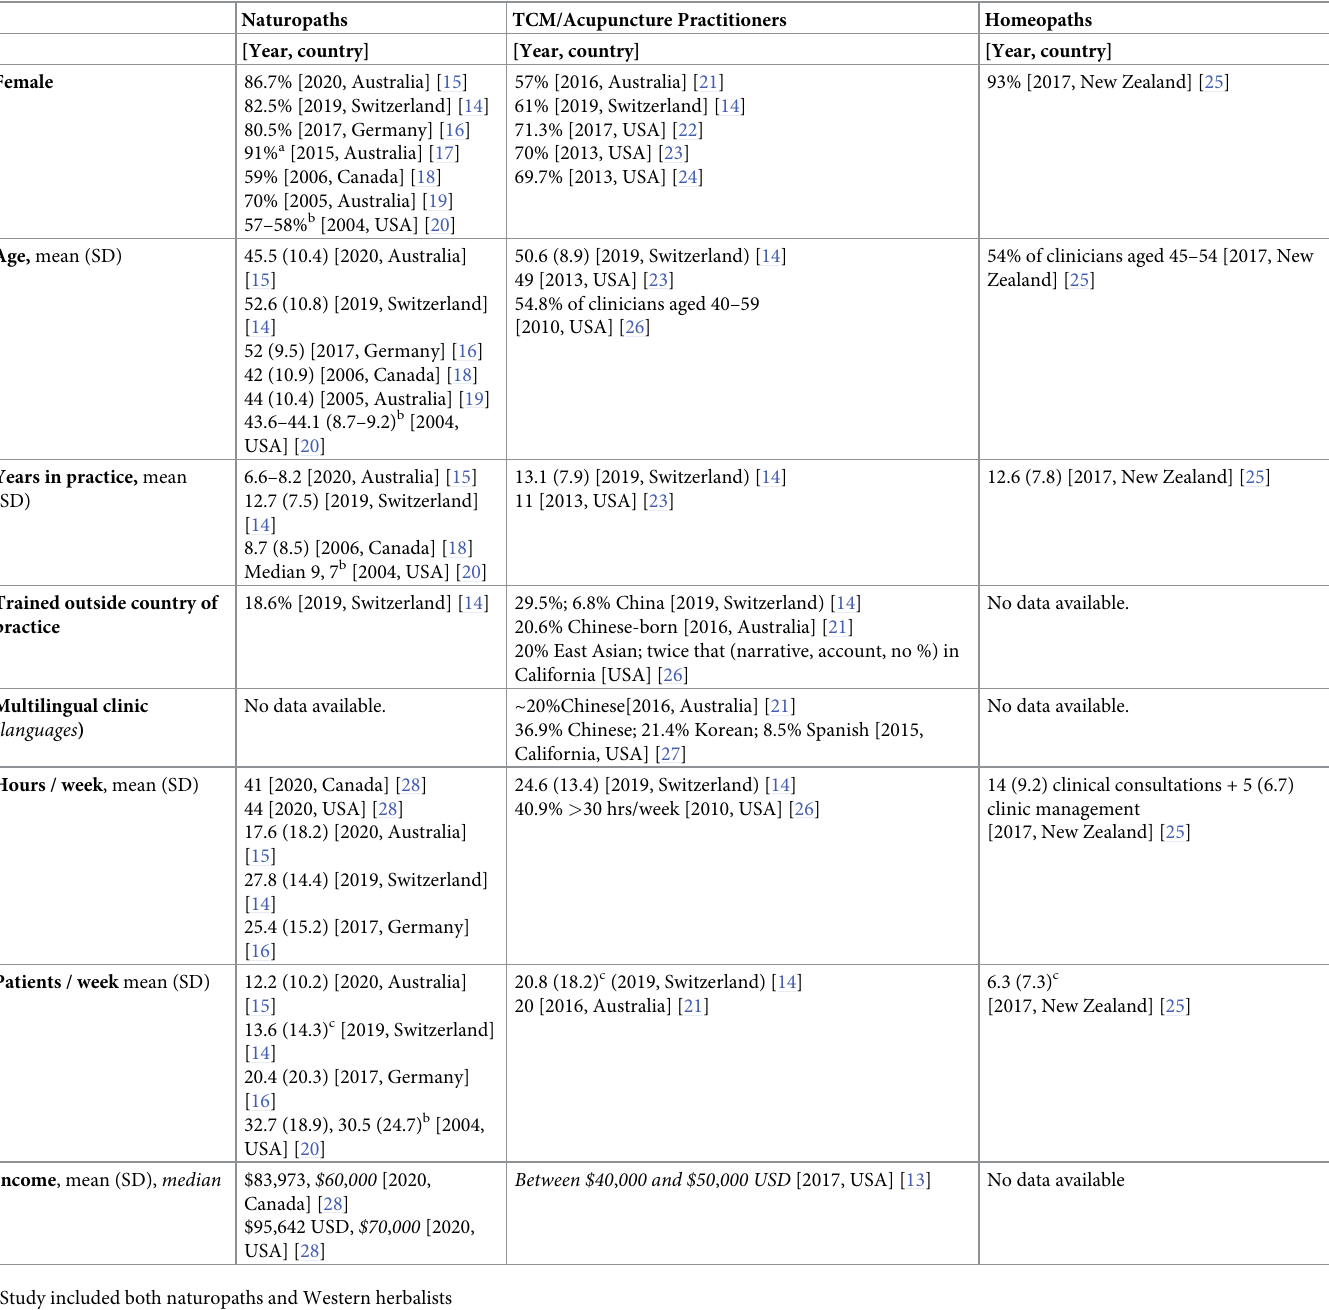
Table 1. Workforce profiles of naturopaths, TCM/acupuncture practitioners, and homeopaths across industrialized